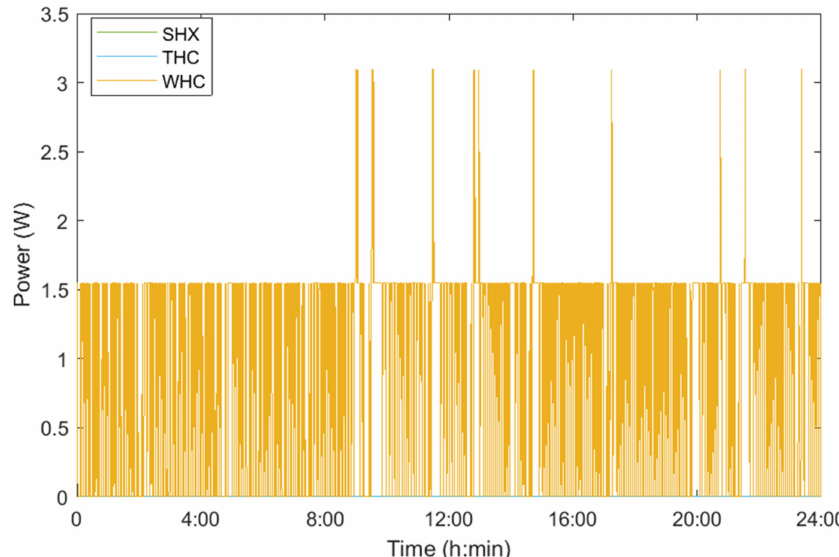
Figure 3. Daily space-heating scaled load profile for the single-family house in Jordan during day types SHX, THC and WHC, scaled according to VDI-4655 guidelines. Space-heating demand during THC and WHC day types is zero.